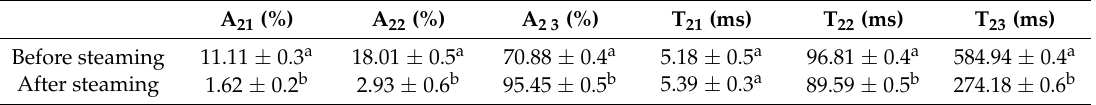
Table 1. Changes in relaxation time and peak area of G. elata before and after steaming.